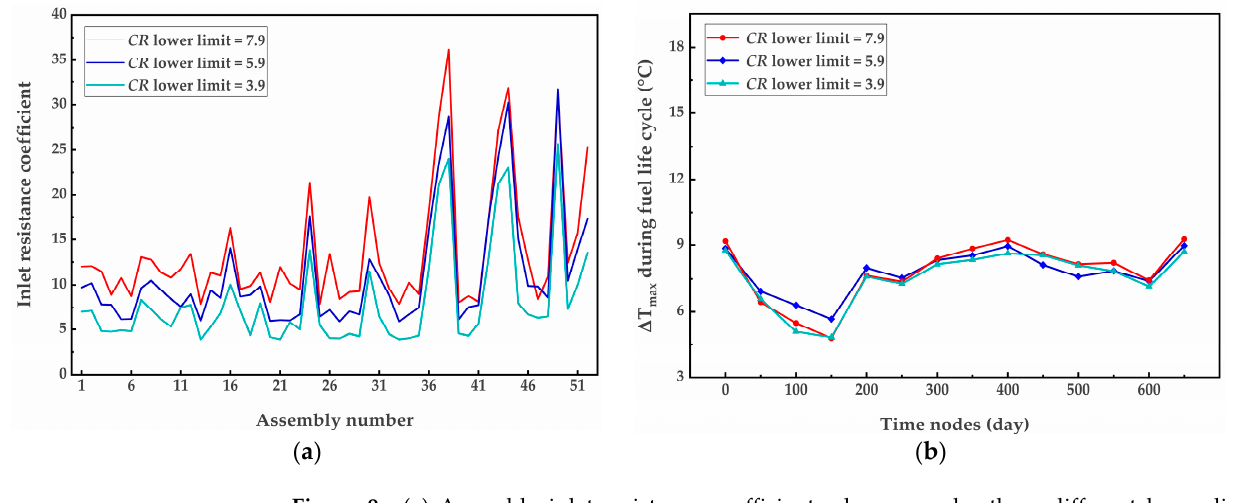
Figure 9. ( a ) Assembly inlet resistance coefficient schemes under three different lower limits; ( b ) ∆ T max,1 during fuel life cycle under three different lower limits.